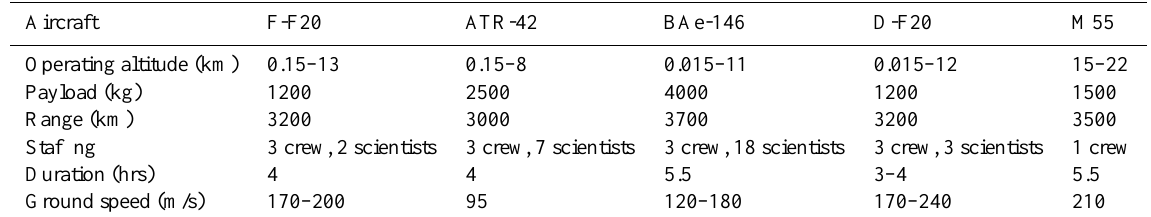
Table 2. Aircraft